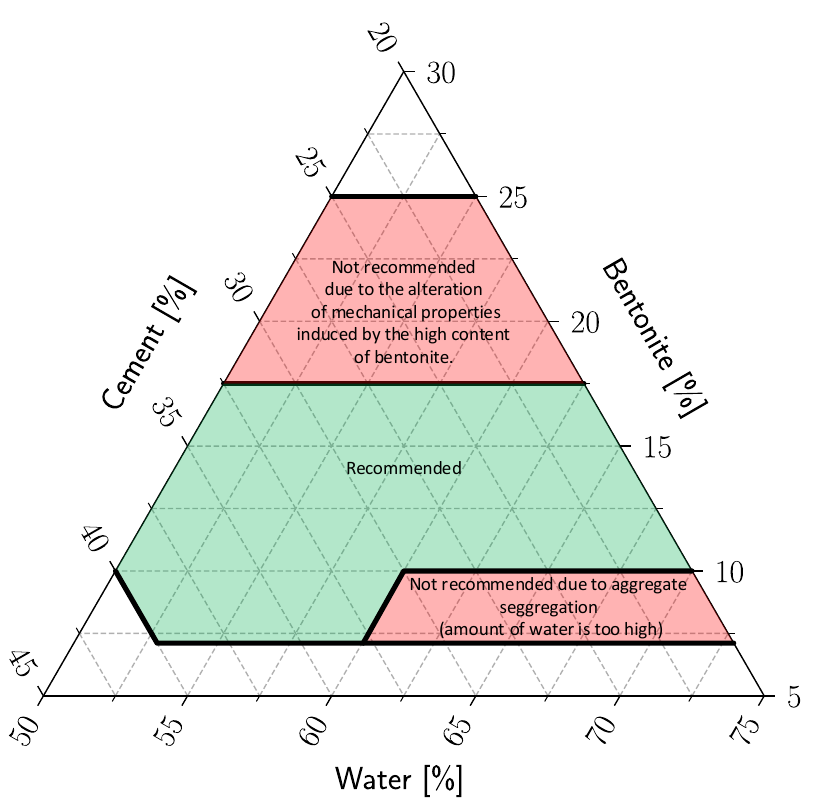
Figure 14. Viscosity vs. water/cement ratio.